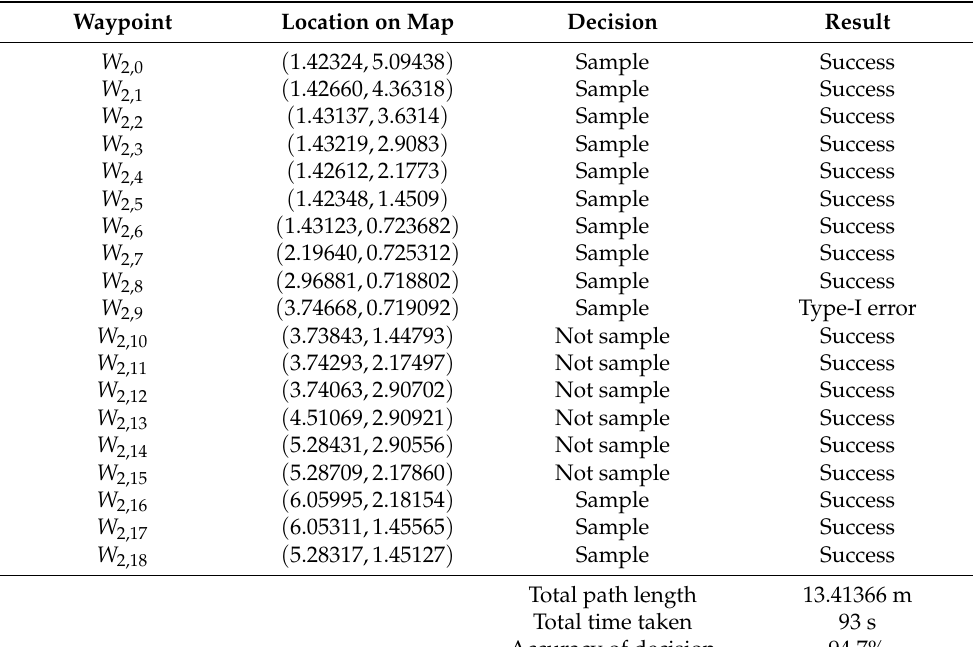
Table 4. The list of locations visited by the robot in trial-2 and sampling decision taken. Waypoint Location on